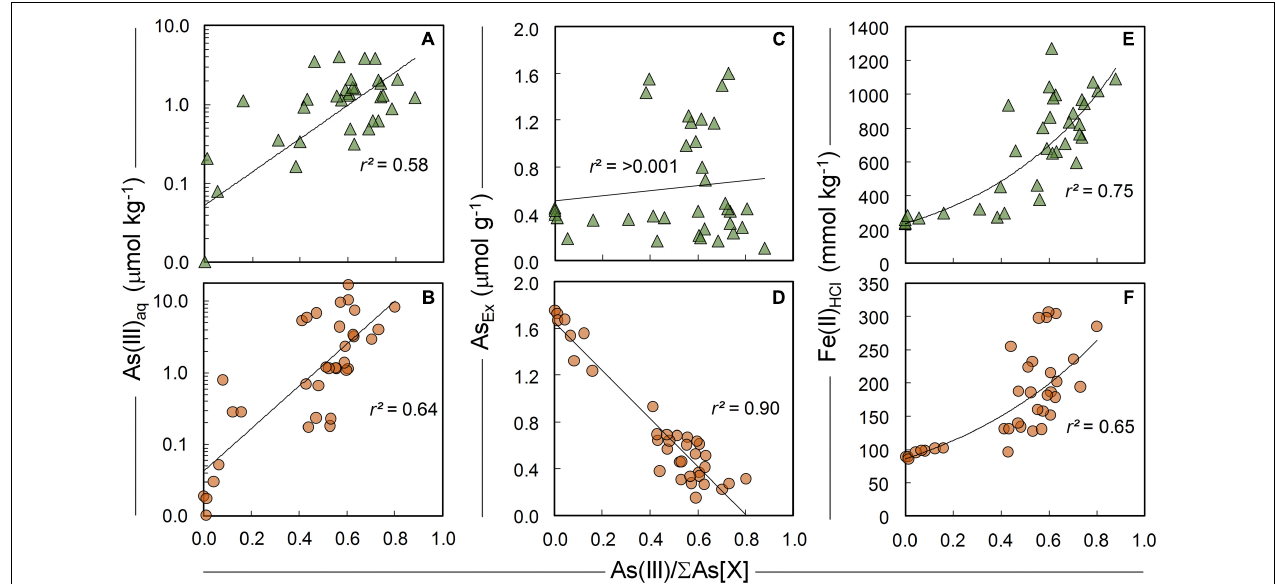
FIGURE 9 | Bivariate relationships between the proportion of solid-phase As(III) species in ferrihydrite:soil (top row, triangles) and goethite:soil (bottom row, circles) treatments and (A,B) As(III) aq species in 1:5 water extracts and (C,D) As Ex and (D,E) concentration of Fe(II) HCl . As(III) determined by linear combination fits of As K-edge XANES